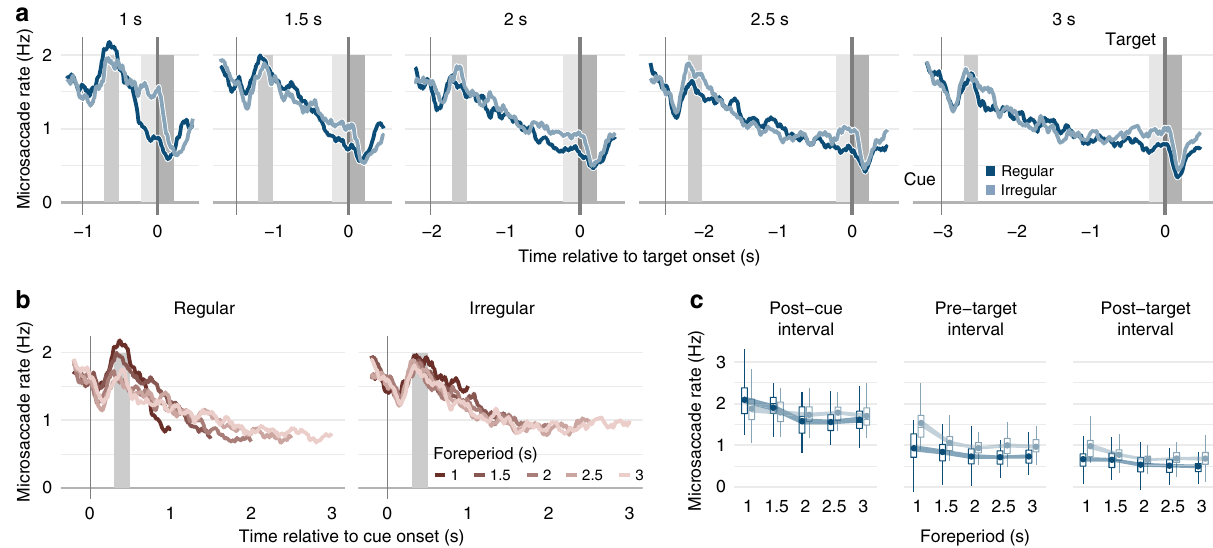
Fig. 3 Microsaccade frequency and temporal predictability. a Group-average microsaccade rates as a function of trial time relative to the onset of the tactile target stimulus separately for each predictability condition (dark blue, regular; light blue, irregular) and foreperiod (panels). Shaded vertical bars indicate the cue and target stimulus (blackish gray), shaded rectangles the post-cue (medium gray), pretarget (light gray), and post-target (dark gray) intervals. b Group-average microsaccade rate timelines relative to the cue onset separately for each predictability condition (panels) and foreperiod (red shades). c Microsaccade rates in a comparison interval 300 – 500 ms after the onset of the tactile cue (left panel), in the 200-ms interval before the onset of the tactile target stimulus (center panel), and in a post-target interval 0 – 200 ms after the offset of the tactile stimulus (right panel), separately for each predictability condition and foreperiod ( x -axis). Boxplots indicate the distribution of participant-level mean values per condition adjusted by their overall interval mean (center line, median; box limits, upper and lower quartiles; whiskers, minimum and maximum limited by 1.5× interquartile range). Circular markers show group-level mean values; the width of the ribbon matches the predictability-condition-adjusted standard error that indicates the degree of intersubject variation in the difference between regular and irregular conditions, and therefore whether there is a signi fi cant effect of predictability condition on microsaccade rates. All statistics are based on the full dataset ( N = 30 participants, 100 repetitions per condition and participant), and source data are provided as a Source Data fi